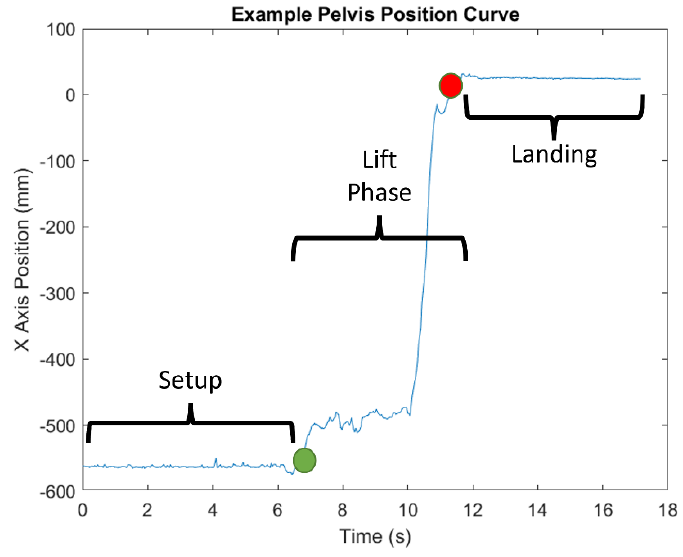
Figure 4. Example of x -axis position of the pelvis marker and the different phases of transfer. Table 2. Key variables used in analysis of sensor reliability and agreement.